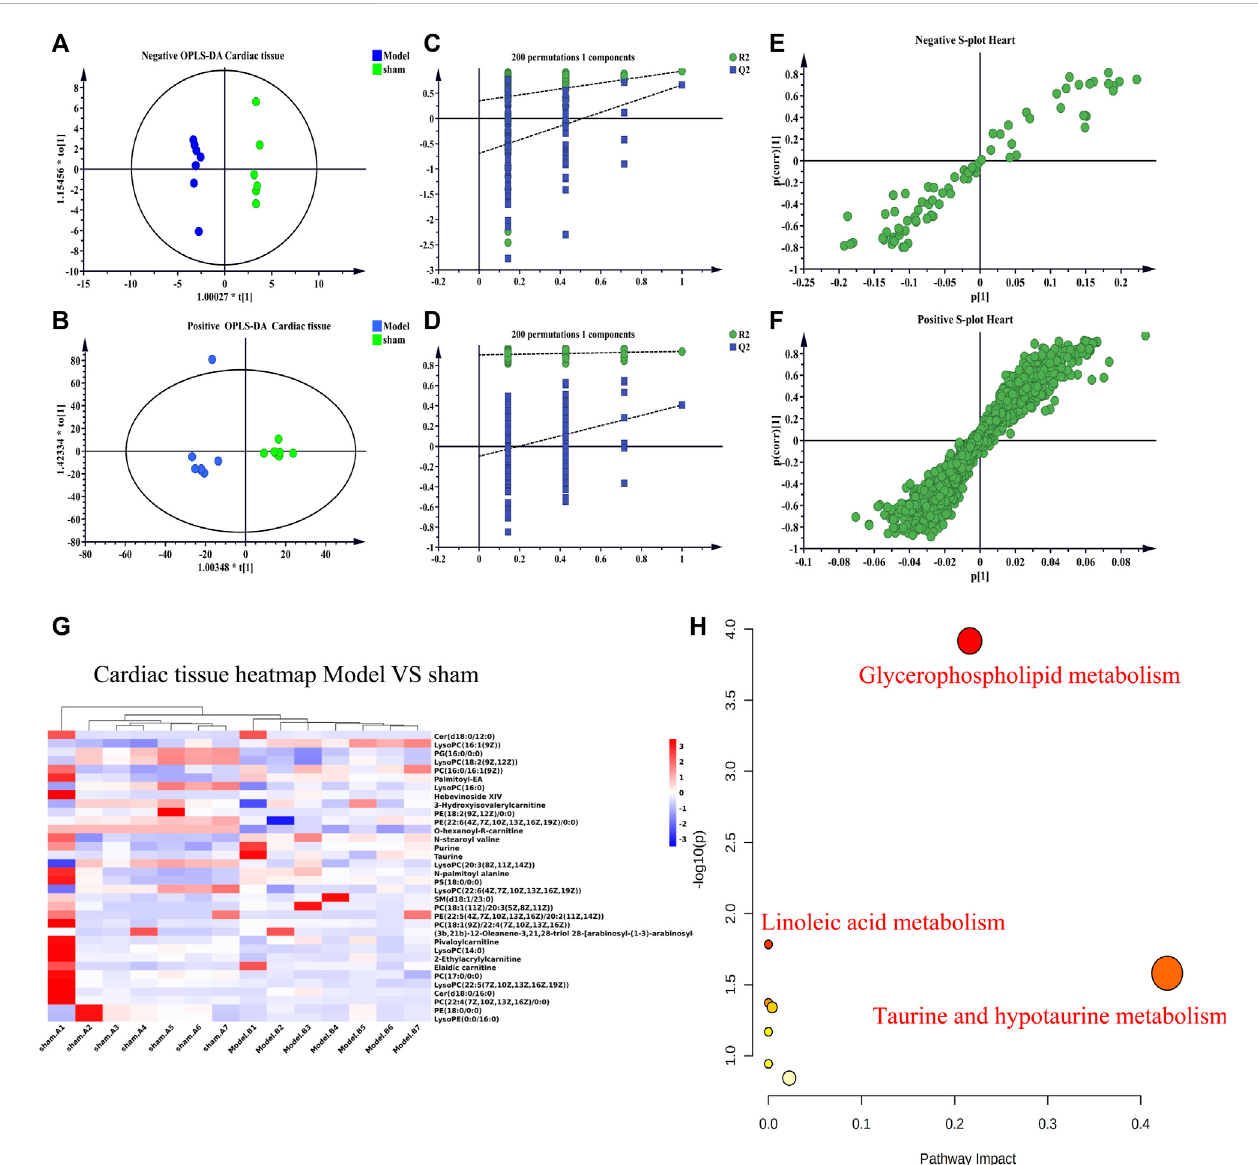
FIGURE 8 Multivariate statistical analysis of cardiac tissue in sham and model groups of rats. (A – B) OPLS-DA score plots of sham and model groups. (C – D) validation plots after 200 replacement tests. (E – F) S-plots of sham and model groups from the OPLS-DA model. (G) Heatmap of chronic heart failure rats. (H) plots of metabolic pathways associated with chronic heart failure rats. (A, C, E) negative mode; (B, D, F) positive